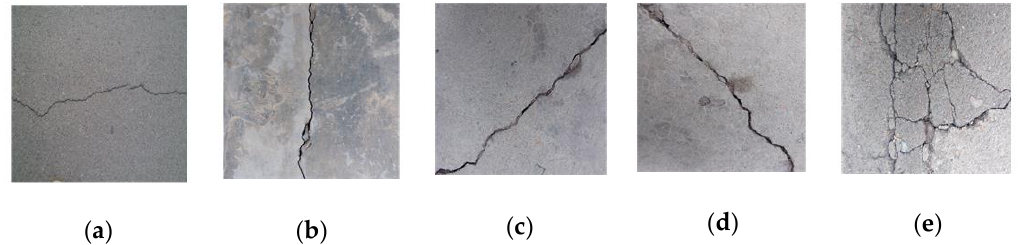
Figure 11. Five crack types: ( a ) transverse cracks; ( b ) vertical cracks; ( c ) left oblique cracks; ( d ) right oblique cracks; ( e ) mesh cracks.